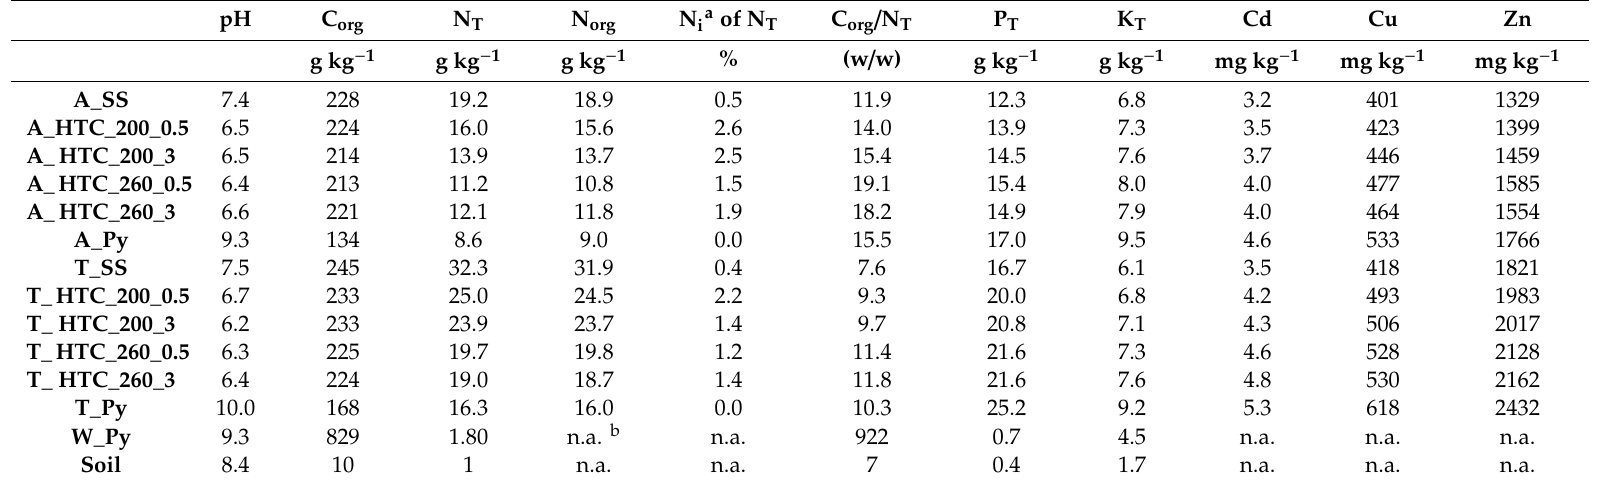
Table 1. The pH, organic carbon (C org ), total nitrogen (N T ), organic nitrogen (N org ), inorganic nitrogen (N i ) of N T , C org / N T ratio, P T , K T , Cd, Cu, and Zn contents of primary (A_SS) and secondary (T_SS) sewage sludges and the respective hydrochars produced at 200 ◦ C (_HTC_200) and 260 ◦ C (_HTC_260) for 0.5 and 3 h (_0.5, _3, respectively), as well as the pyrochars (_Py)